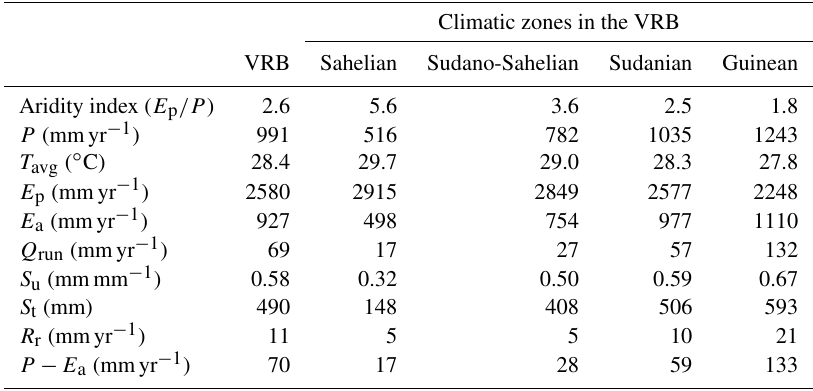
Table 3. Annual average of hydroclimatic variables per climatic zones corresponding to the median of all RCM–GCM combinations and all RCPs over the historical